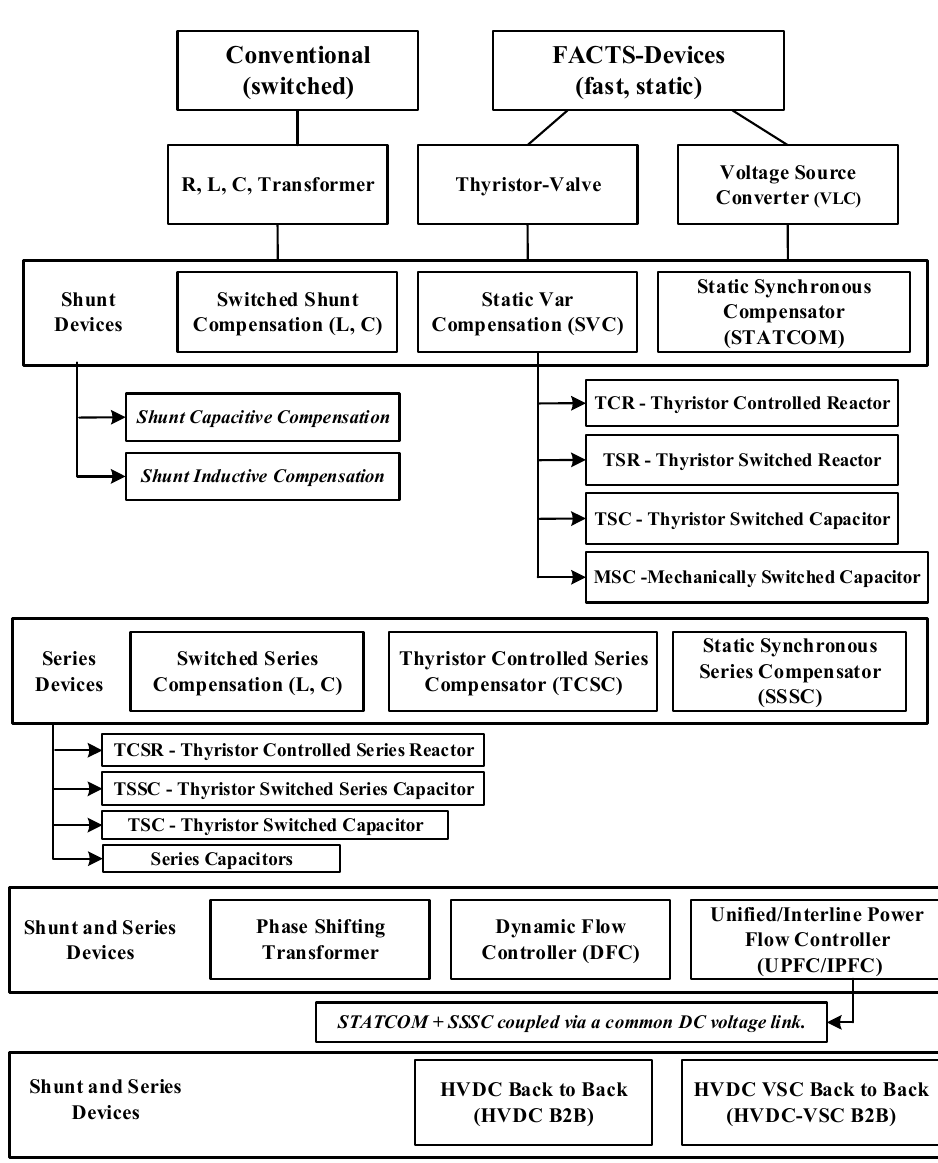
Figure 3. Overview of the major FACTS devices.